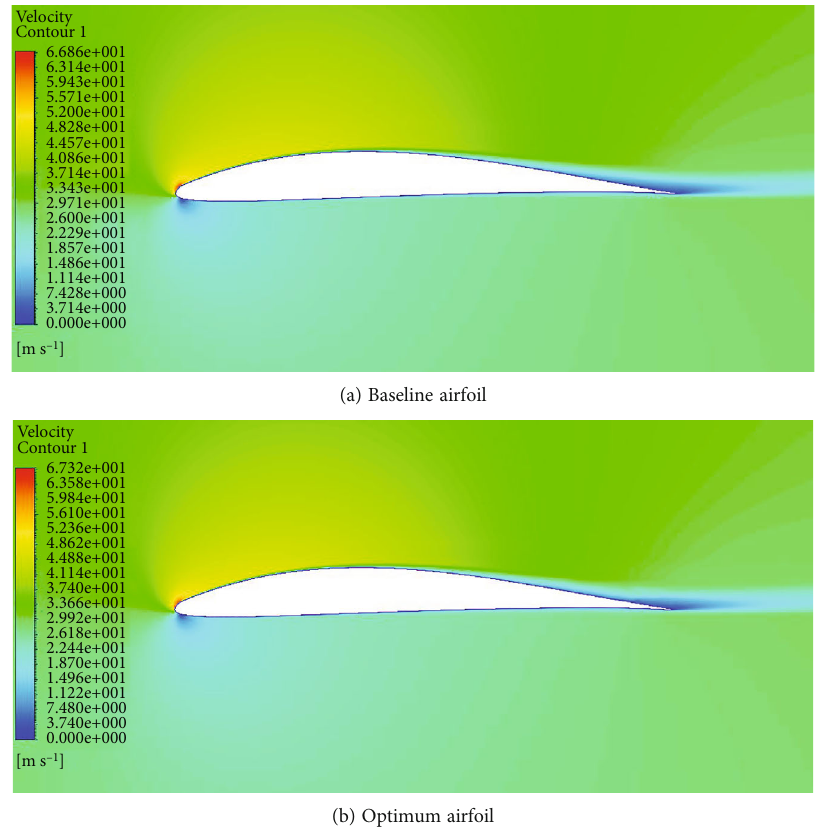
Figure 13: Comparison of fl ow fi eld velocity cloud for baseline and optimum